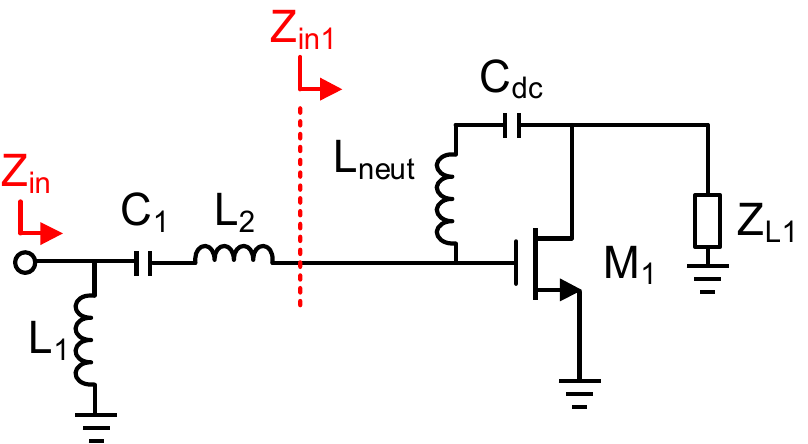
Figure 4. Input matching network of the first gain stage.